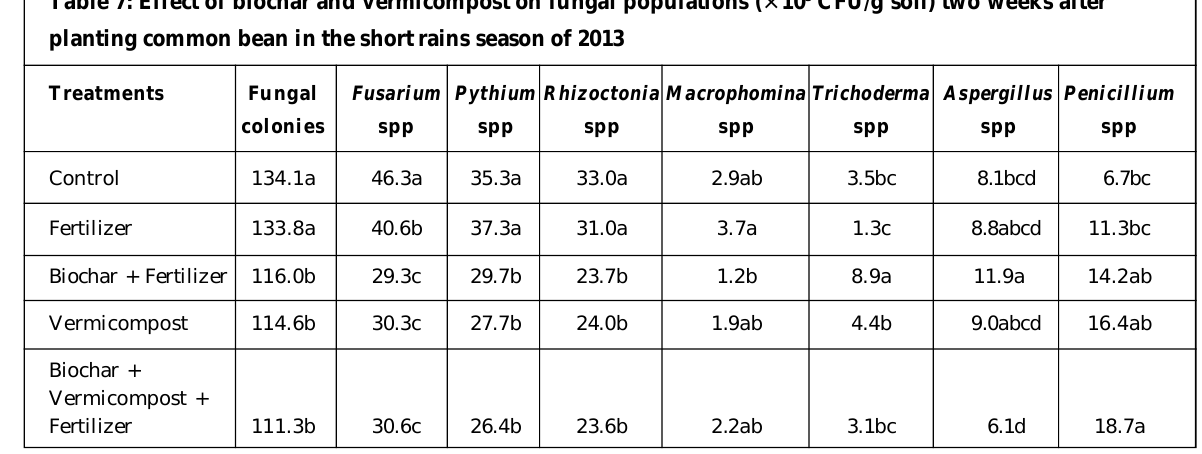
Biochar + Fertilizer